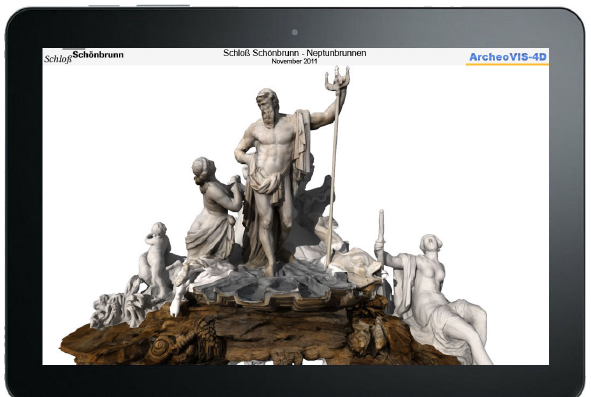
Figure 8. 3D rendering on tablet PC using image texture, bump mapping and artificial lightning.